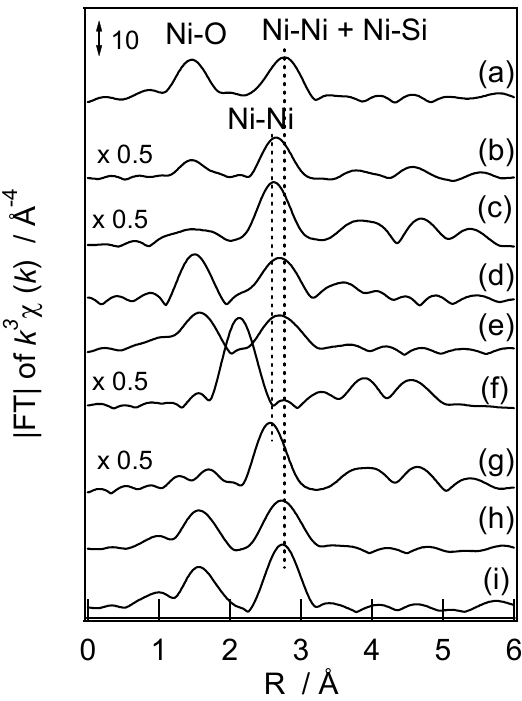
Figure 8. Fourier transforms of k 3 -weighted EXAFS spectra of ( a ) Ni-M41; ( b ) Ni/M41; ( c ) Ni/SiO ; ( d ) Ni-NH /M41; (e ) Ni-NH /SiO ; ( f ) Ni foil; ( g ) NiO; ( h ) Ni-silicate 2 3 3 2 (antigorite); and ( i ) Ni-silicate (talcite). Δ k : 3.2–12 Å − 1